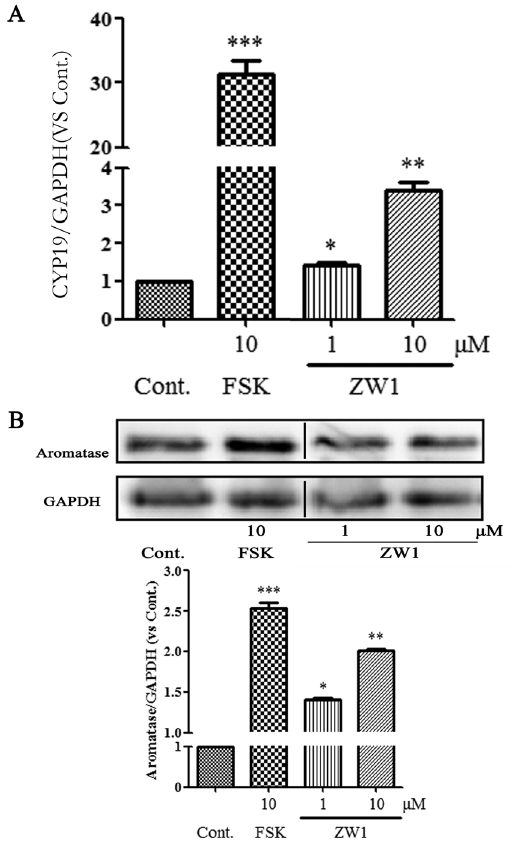
Figure 5. ZW1 promotes aromatase expression in KGN cells. KGN cells were treated with the test compounds at the indicated concentrations for 24 h. ( A ) Aromatase mRNA was measured in total cellular RNA by using real-time qPCR. The results were presented as the n-fold change relative to the basal levels in untreated cells. GADPH was used as an internal control. ( B ) The cell lysates were immunoblotted with an anti-aromatase or anti-GAPDH antibody. Cont., DMSO-treated control; FSK, 10 μ M forskolin; LET, 1 μ M letrozol. * p < 0.05, ** p < 0.01, *** p < 0.001 compared with the control ( n = 3). Black line represents one band removed, which was treated by formestane. The full western blot and the corresponding positions of the molecular weight protein markers are presented in Supplementary Fig.